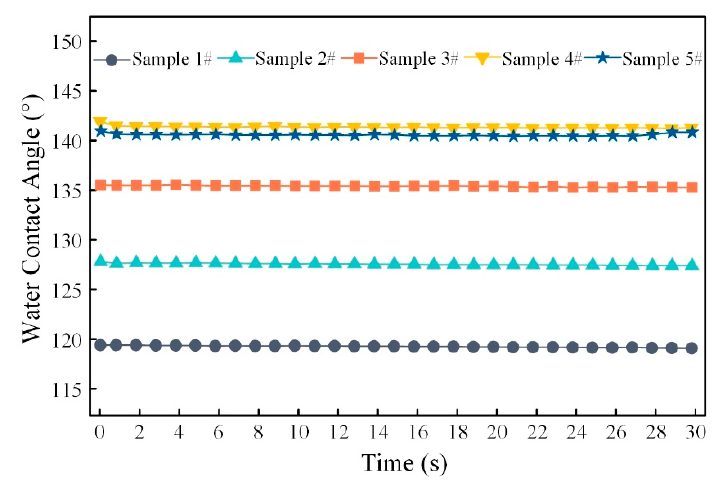
Figure 11. Droplet wettability state at different filling depths of micro-structures: ( a ) Wenzel state; ( b ) Cassie-Baxter state.